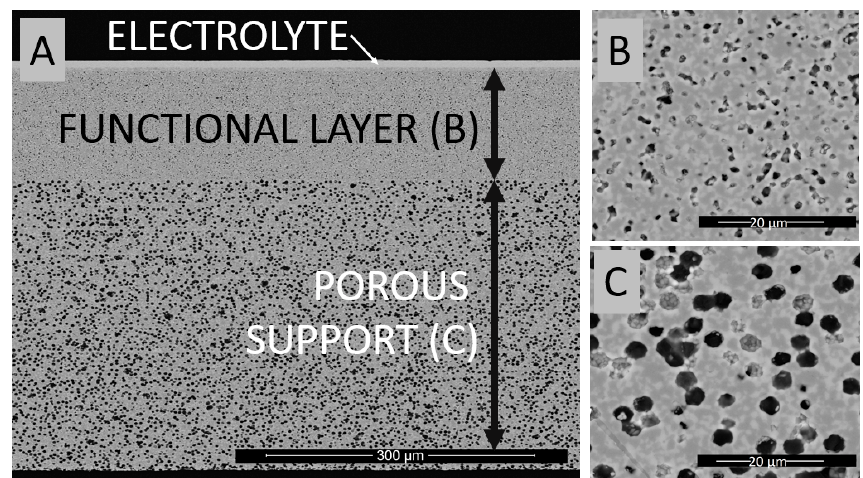
Figure 1. Micrograph of half-cell made using tape casting technique and consisting of two layers of NiO-yttria-stabilized zirconia (YSZ) and YSZ electrolyte: ( A ) overview of the half-cell; ( B ) magnification of the functional layer; ( C ) magnification of the porous support layer.